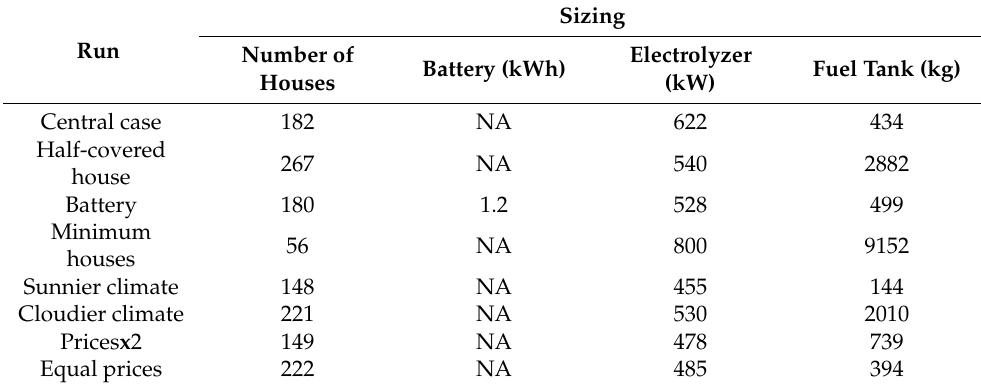
Table 6. Results of the optimization.